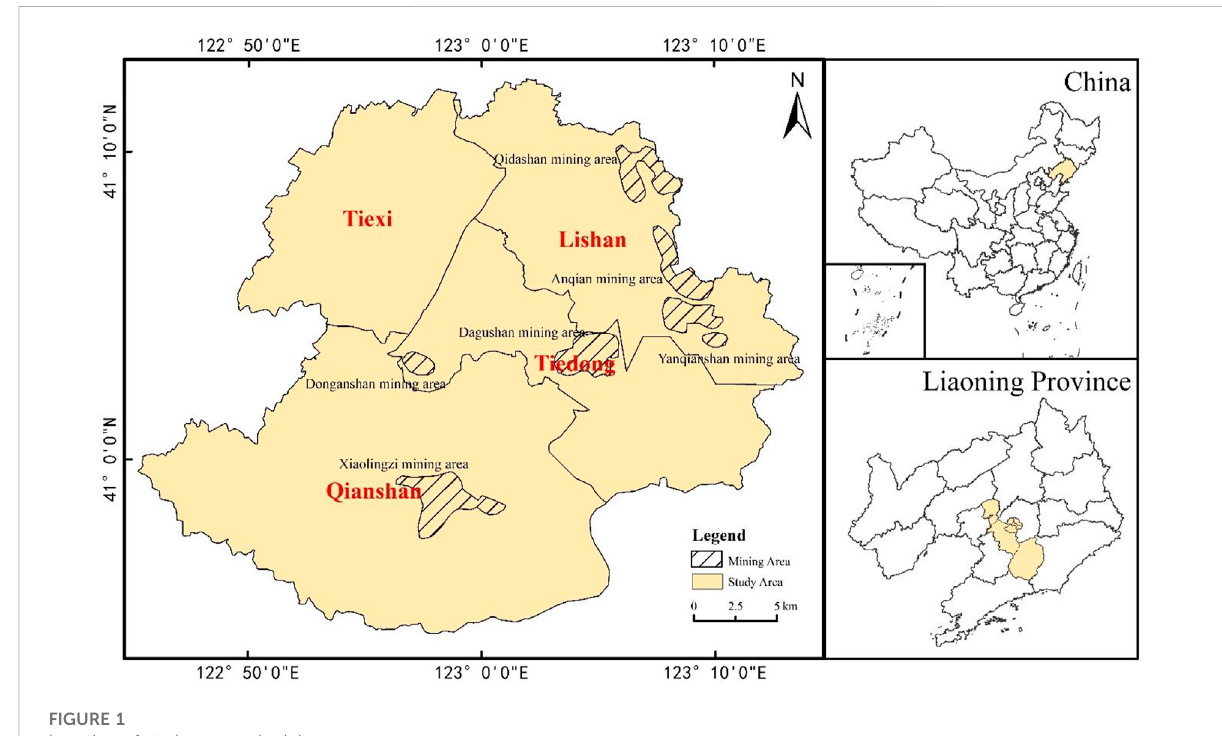
FIGURE 1 Location of study area and mining